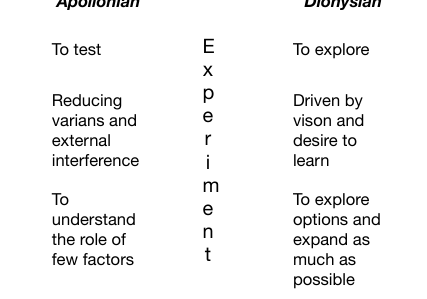
Fig. 1. Visionary experiments that introduces suggestions for new understanding and meaning does not need detailed plans or change management, but is guided by visions and a desire to explore and learn while experimenting. The Apollonian experiment seeks to control and reduce risk, while Dionysian experiments regards ambiguity as a potential